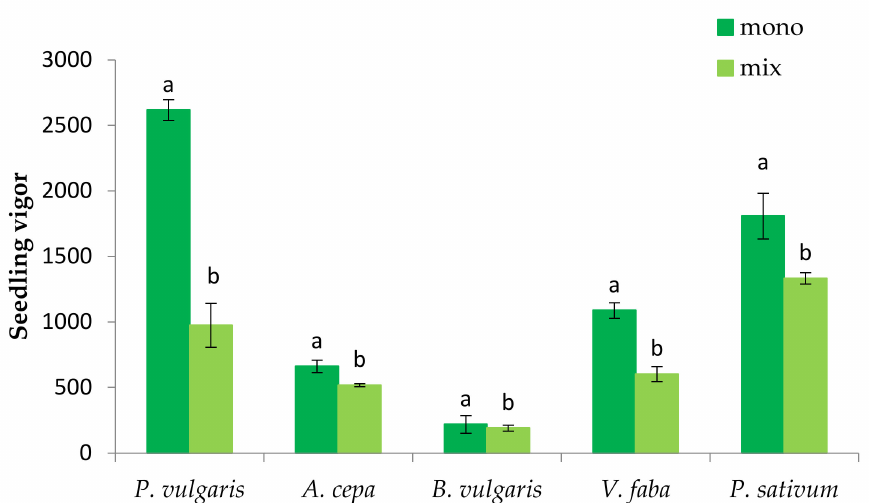
Figure 4. Seedling vigor of crop species grown together with P. oleracea seeds (mono = only crop plant; mix = crop grown together with P. oleracea ). Bars represent the means of 4 replicates ± SE. Bars topped by the same letter indicate no significant difference between treatments at the 5% level using Duncan’s multiple-range test.